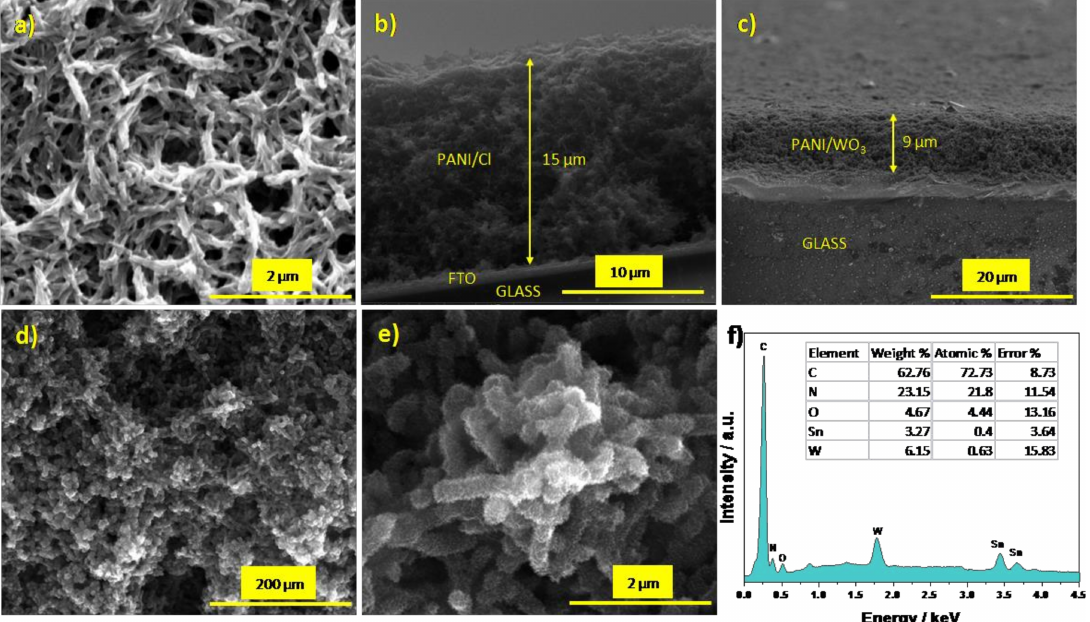
Figure 2. ( a ) SEM image of FTO / PANI / Cl; a cross-section SEM image of ( b ) FTO / PANI / Cl and ( c ) FTO / PANI / WO 3 ; ( d , e ) SEM images of FTO / PANI / WO 3 and ( f ) EDX spectrum of FTO / PANI / WO 3 (inset: a table with listed elements